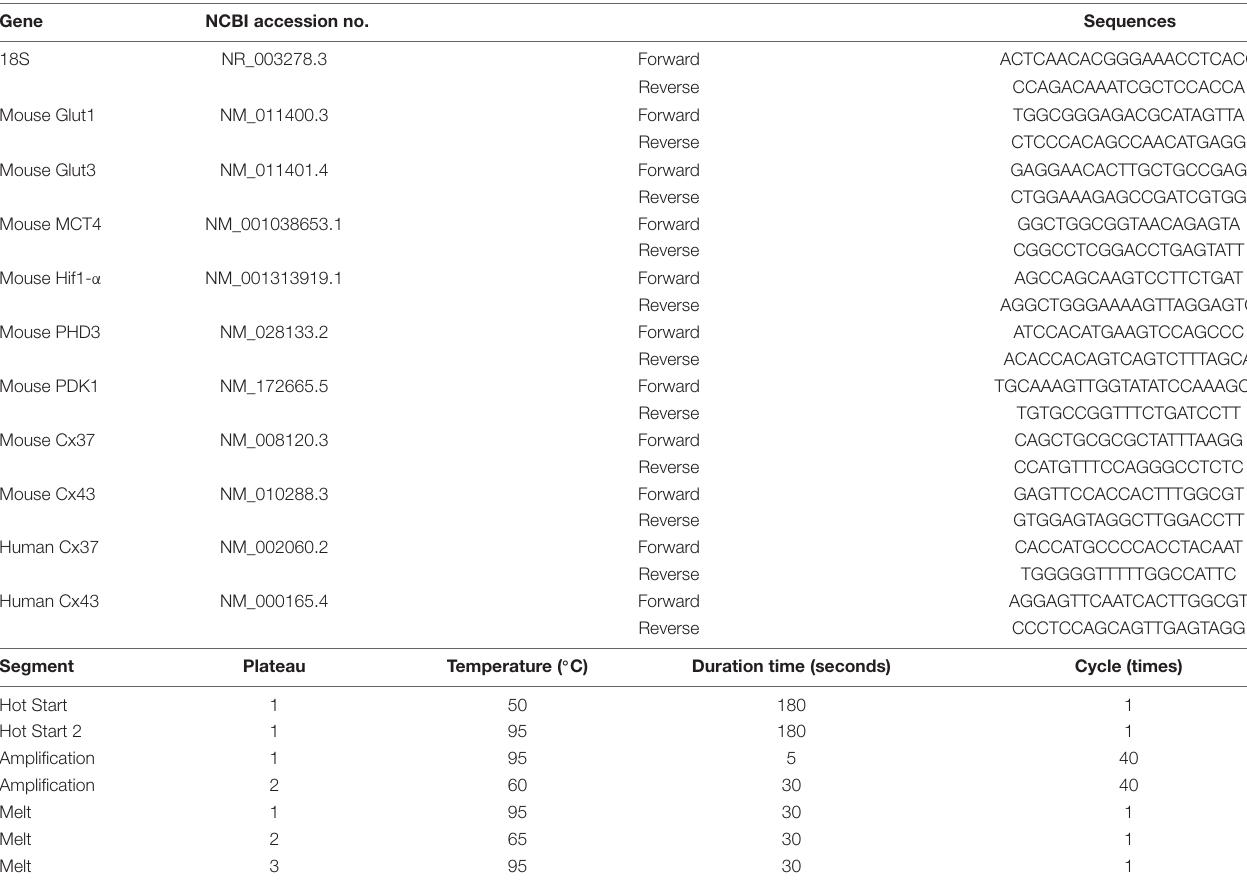
TABLE 1 | Target genes, primer list and amplification protocol of qPCR. Gene NCBI accession